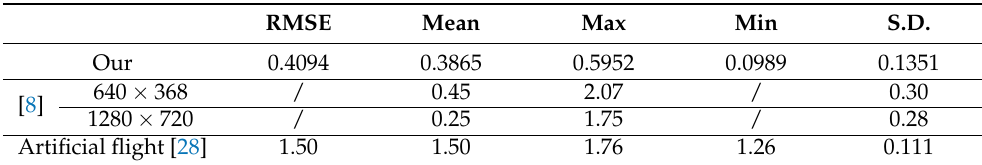
Table 9. Comparison of geographical UAV